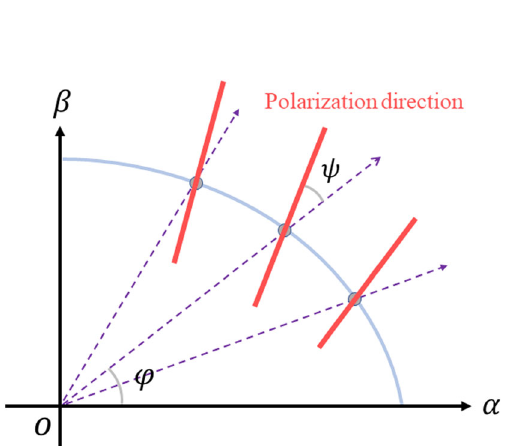
Fig. 5 A diagram of an angle between the polarization vector and the radial vector at (ρ,ϕ) in the α − β